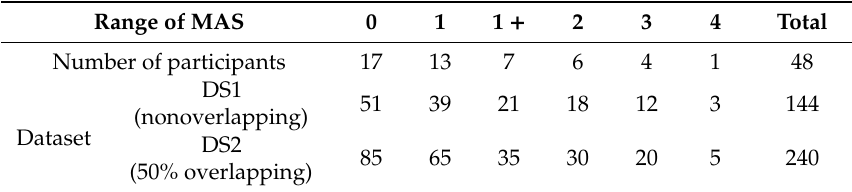
Table 4. Results of MAS obtained with study participants recruited (n = 48) and number of data samples segmented by two di ff erent